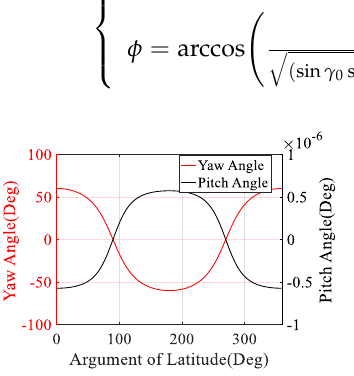
Figure 2. Pitch and yaw angles along the orbit. Table 1. System parameter. Then, the variation curves of the squint angle and look-down angle in a satellite period are drawn in Figure 3.